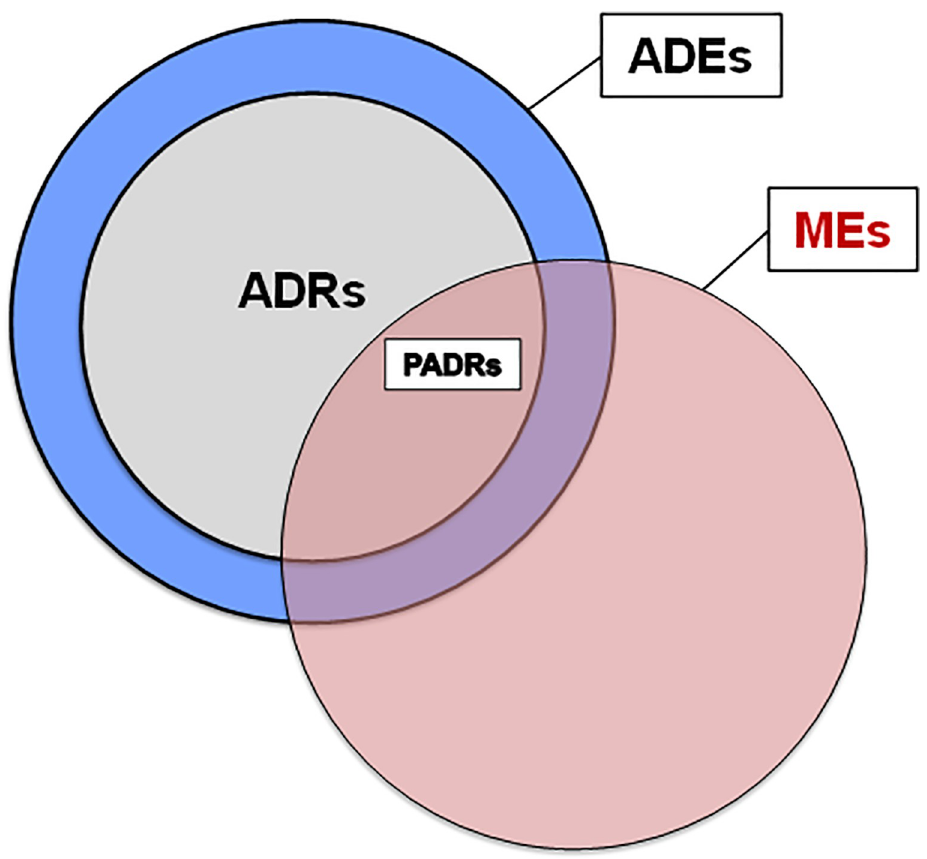
Fig 1. Venn diagram of adverse event